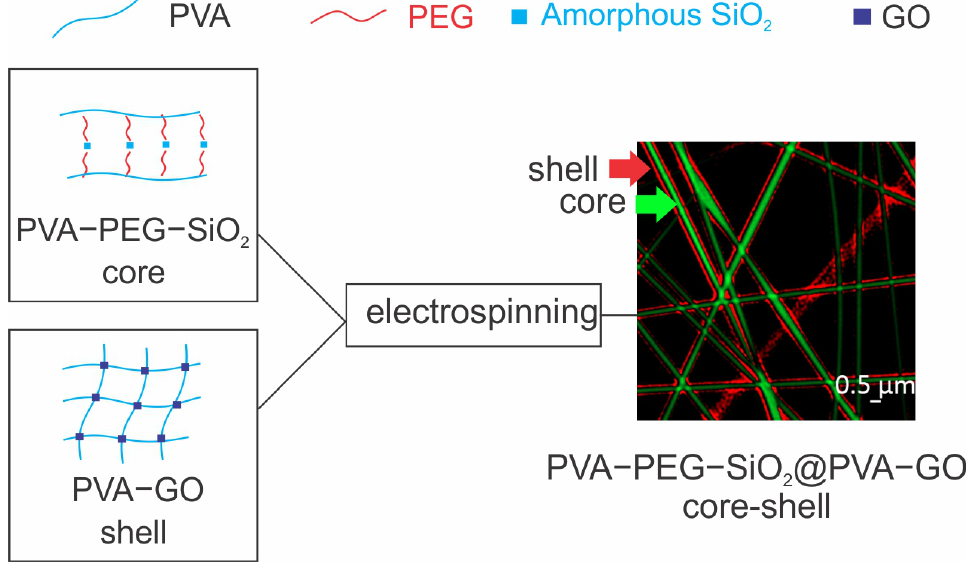
Figure 1. Schematic of fabrication of core–shell fiber composite PVA-PEG-SiO 2 @PVA-GO [30]. Based on the cumulative characterization retrieved from [30], the PVA-PEG-SiO 2 core and core–shell PVA-PEG-SiO 2 @PVA-GO fibers have a mean diameter of 364 ± 69 nm and 261 ± 51 nm, respectively, as presented in Figure